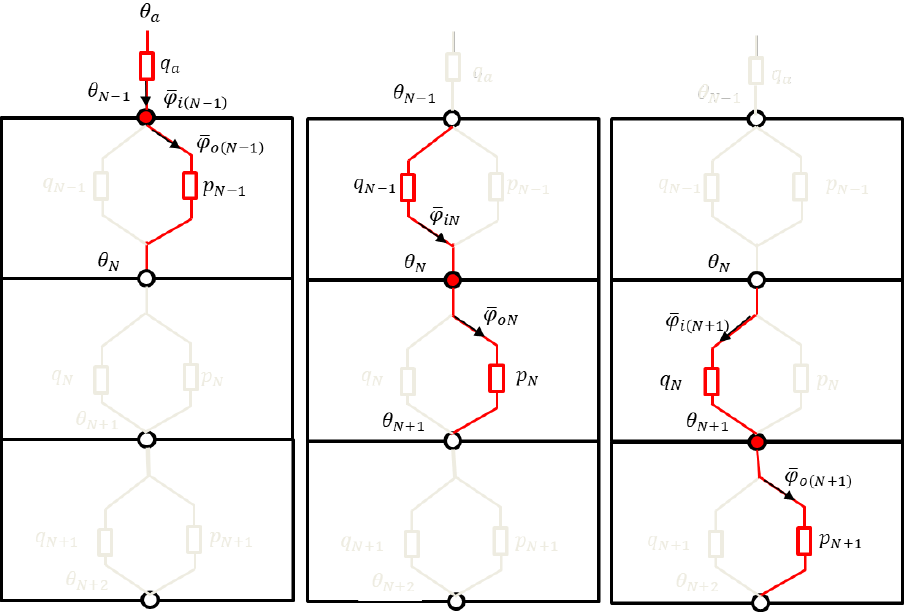
Figure 2. The substitutive coefficients network scheme.